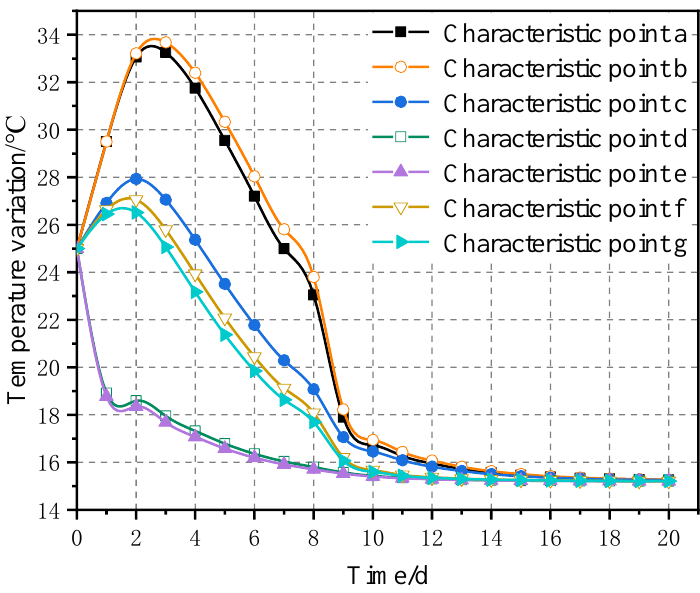
Figure 9. Initial temperature variation control curve.